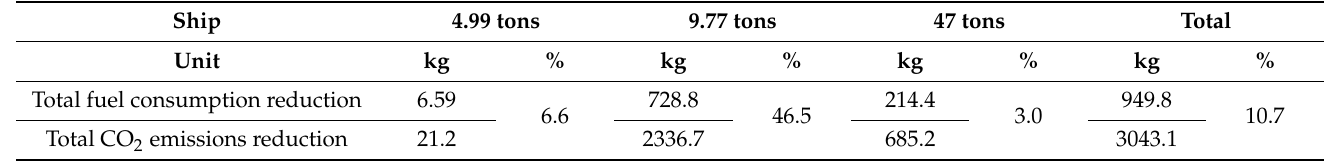
Table 5. CO 2 emissions of proposed battery hybrid fishing boats ECMS in idling and